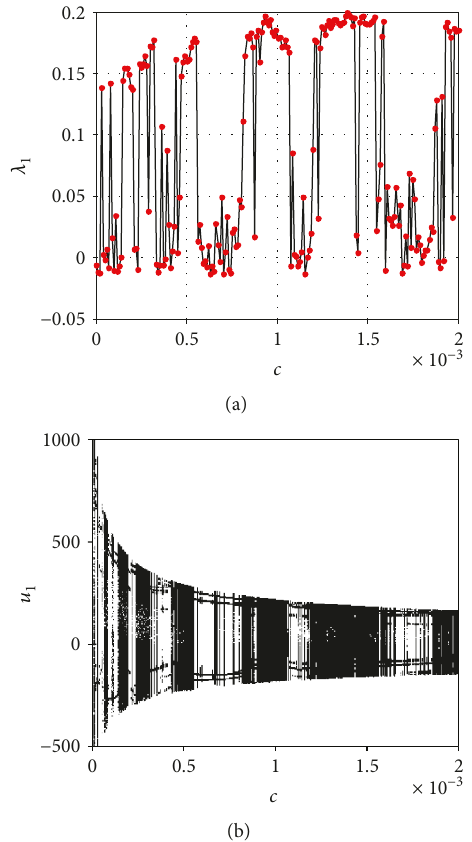
Figure 2: (a) Largest Lyapunov exponent for the variation of c and (b) bifurcation diagram for the variation of c